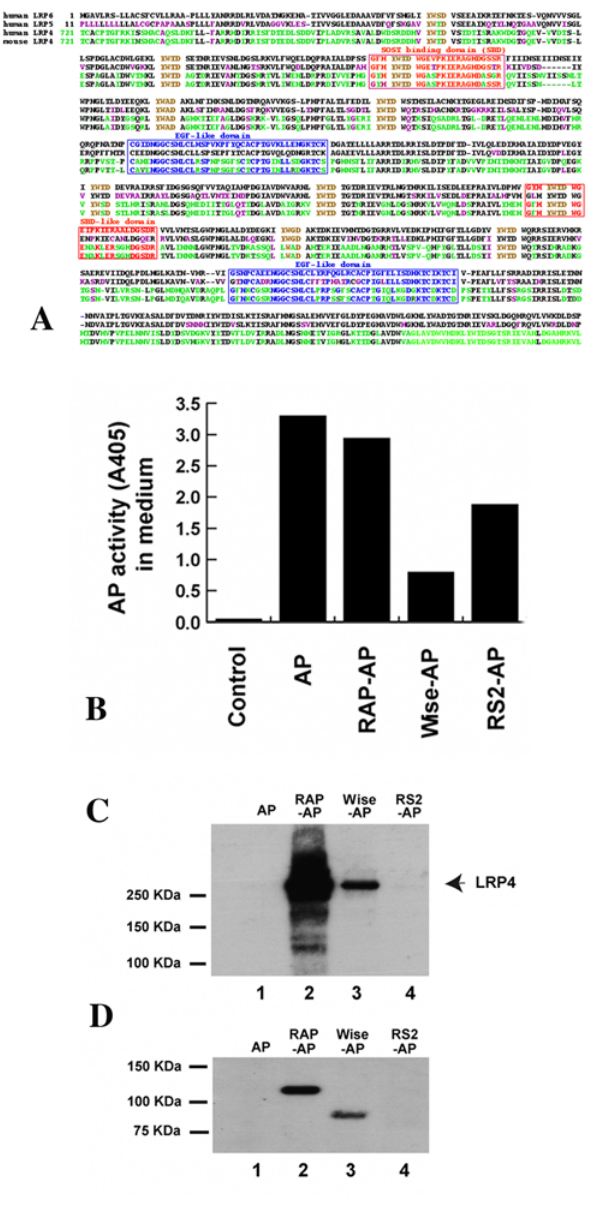
Figure 1. RAP and Wise, but not AP and RSpondin2 (RS2), bind to LRP4. (A) Sequence alignment of Lrp4, Lrp5 and Lrp6. Alignment of amino acid sequence of EGF-like repeats 1 and 2 of mouse in the extracellular domains of Lrp5/6 and Lrp4. (B) Media containing AP or AP-tagged proteins were produced by transfection of HEK293A cells with indicated constructs for 48 hrs. AP activity measured in media shows various expression levels and no presence of AP in control medium. (C) HEK293A cells expressing LRP4 were incubated in equal volumes of media containing indicated proteins, treated with a cross- linker dithiobis[succinimidylpropionate], and lysed prior to analysis of LRP4-binding proteins by immunoprecipitation with anti-AP antibody followed by immunoblotting with anti-LRP4 antibody. (D) LRP4 ectodomain fused with human Fc was produced as a secreted protein, conjugated to Protein A-Agarose, and incubated in equal volumes of media containing indicated proteins prior to analysis of LRP4 binding proteins by immunoblotting with anti-AP antibody.